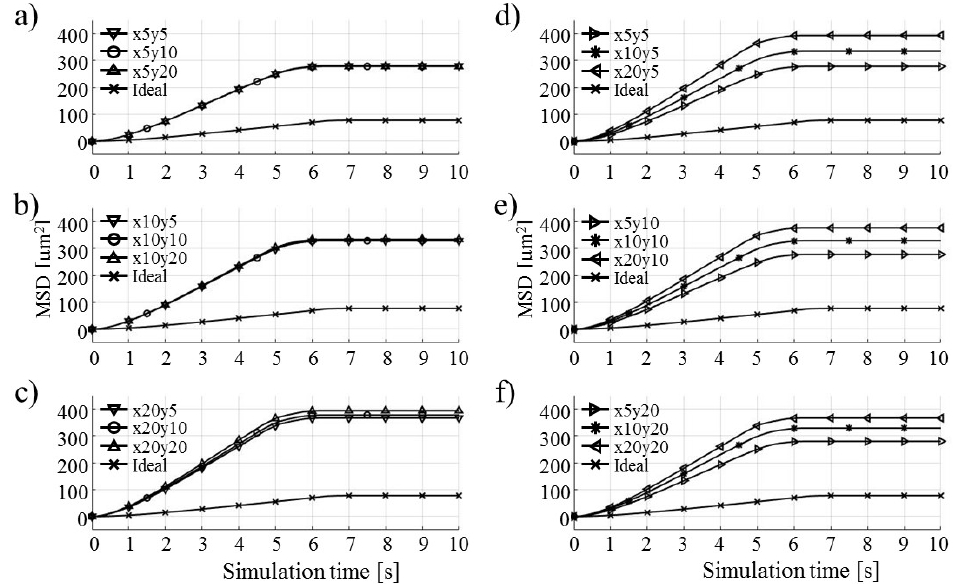
Figure 22. Computed MSD values for parabolic notch electrode shape geometry variations: ( a – c ) varying only half-height y (0.5 h ): 5, 10, 20 ( μ m); ( d – f ) varying only half-width x (0.5 w ): 5, 10, 20 ( μ m).